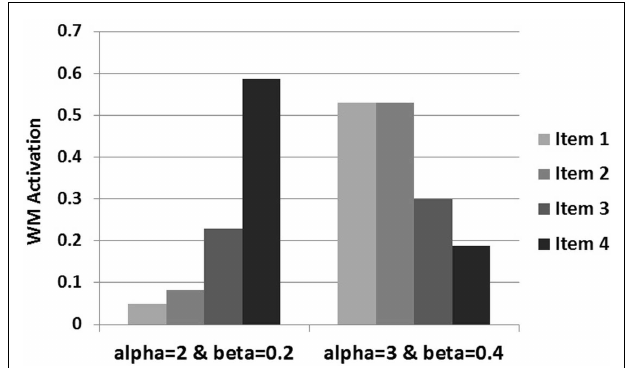
FIGURE 10 | Individual data activations under both levels of alpha and beta.